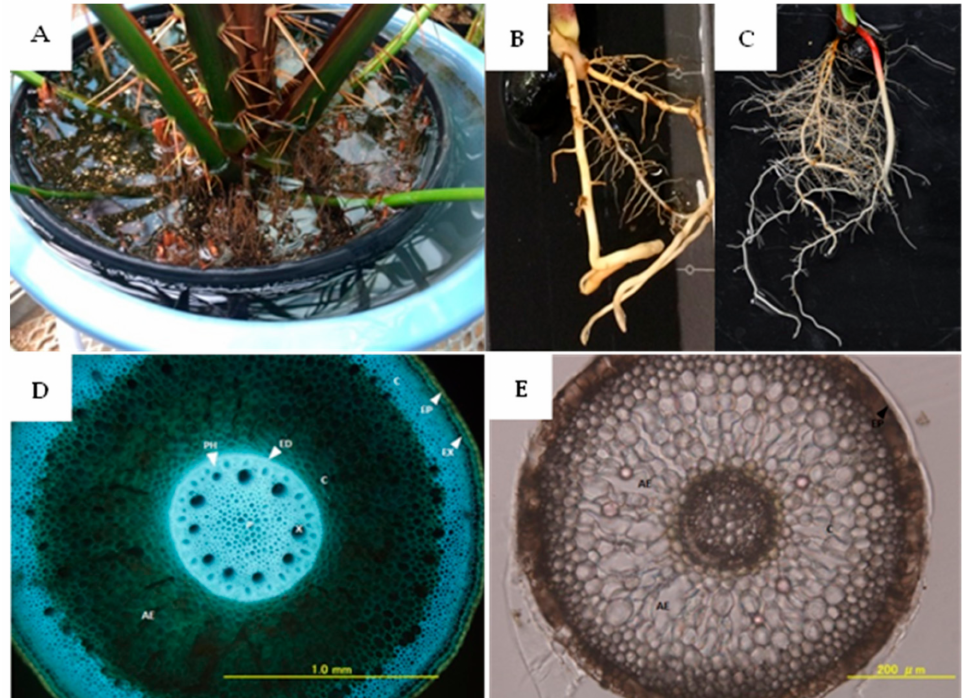
Figure 1. ( A ) Aerial root (pneumatophore) of sago palm seedlings. ( B ) Roots of sago palm seedlings under normal soil water condition and ( C ) waterlogging. ( D ) Aerenchyma tissues in thick (>2 mm) and ( E ) thin pneumatophore (<2 mm).